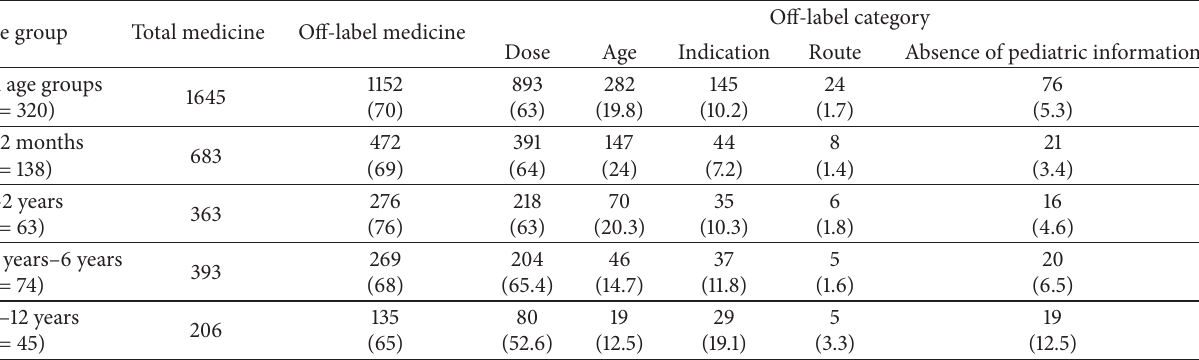
Table 2: Proportion off-label medicine use in different age groups.